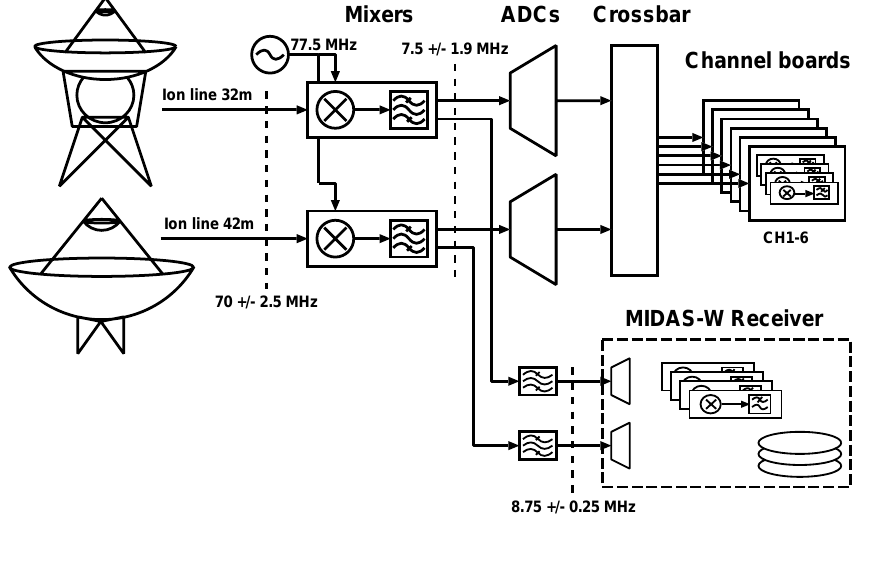
Fig. 1. Block diagram of the ESR ana- log/digital receiver showing the path of the signal through the system and how the MIDAS-W receiver is connected to the existing system. The vertical dashed lines at various points show the center frequency and bandwidth of the signal at those